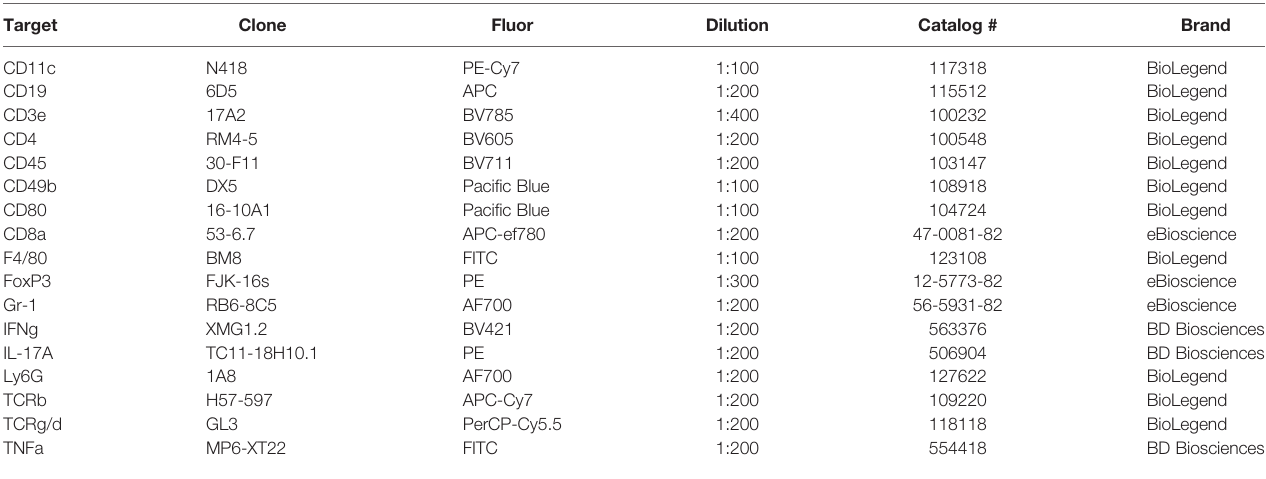
TABLE 1 | Flow Cytometry